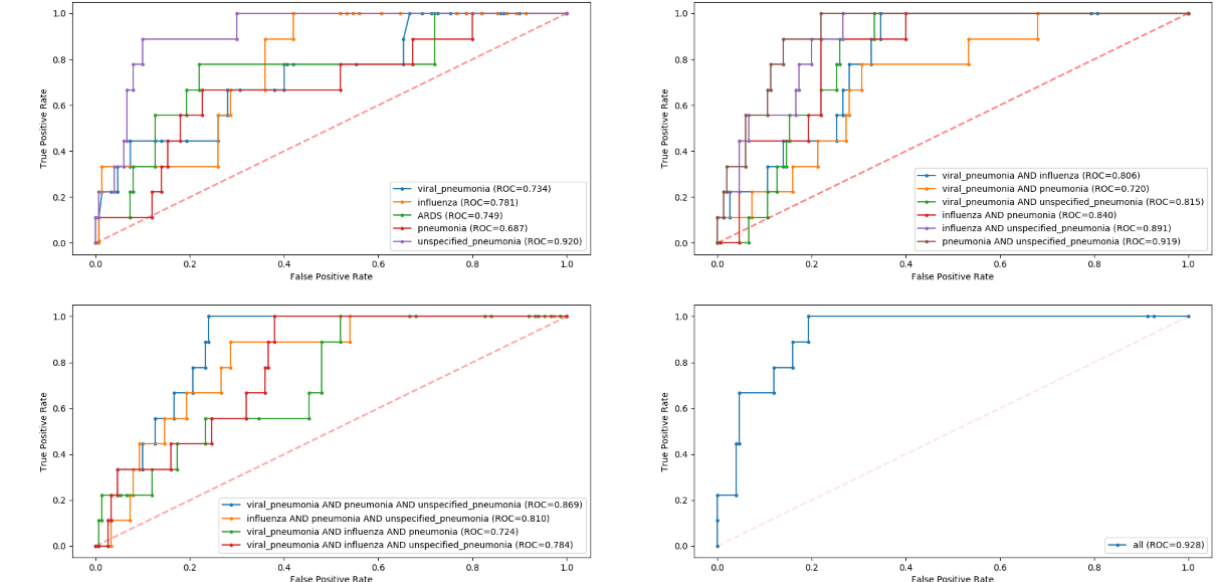
Figure 3. Receiver operating characteristic curves for model performance on predicting inpatient mortality in the COVID-19 cohort, stratified by COVID-19–like cohorts. ARDS: acute respiratory distress syndrome; ROC: receiver operating